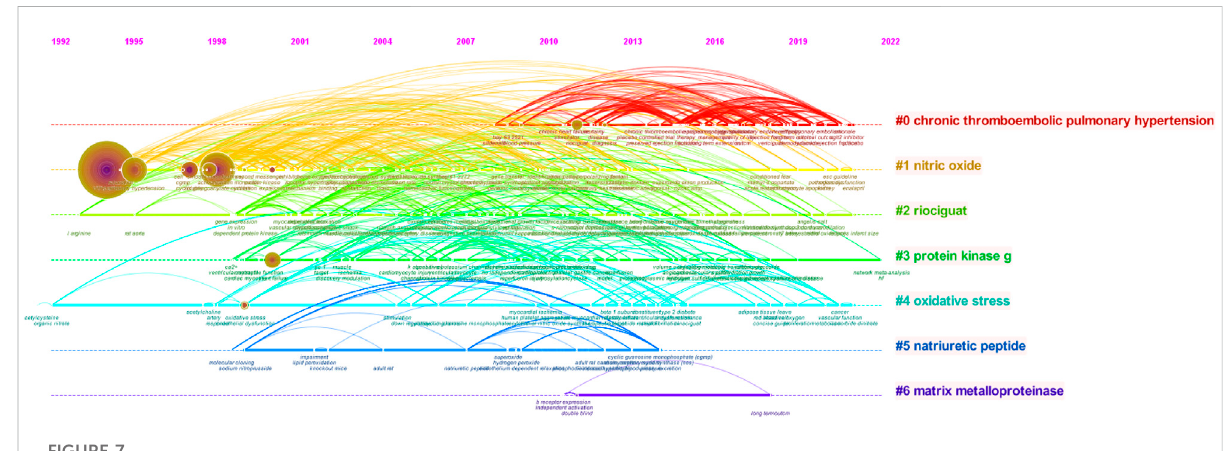
FIGURE 7 Timeline view of keyword clustering related to sGC stimulators in cardiovascular